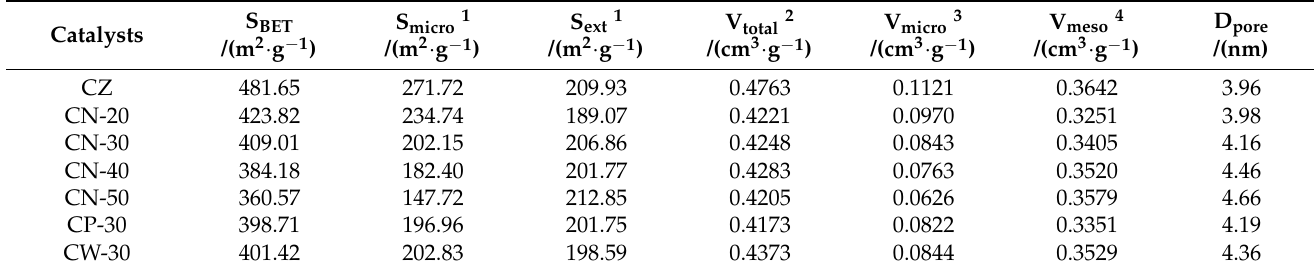
Table 2. Low-temperature N 2 adsorption and desorption results of the